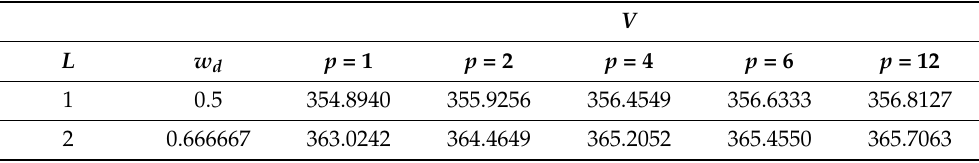
Table 6. Dependence of the company value, V , on leverage level L at different frequency of payments of tax on profit p for six-year company.